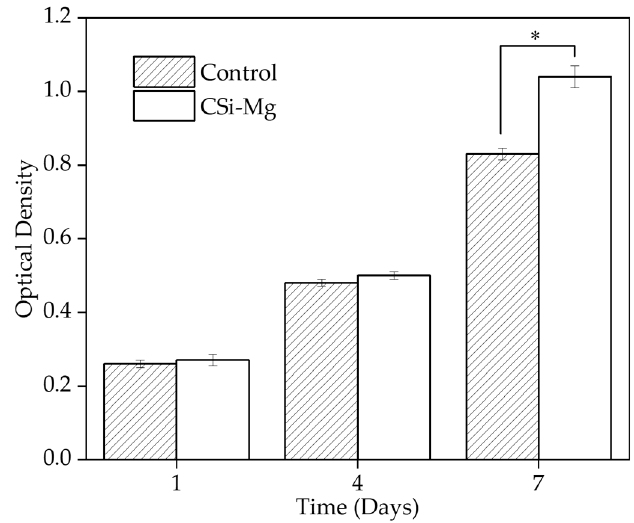
Figure 8. Cell viability at 1, 4, and 7 days (* p < 0.05).